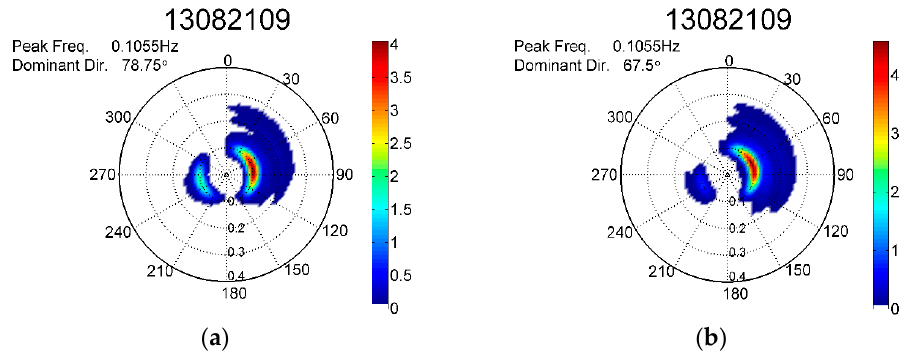
Figure 9. Directional wave spectra obtained at 09:00 on 21 August 2013 from the ( a ) ATC sensor and ( b ) GNSS receiver.